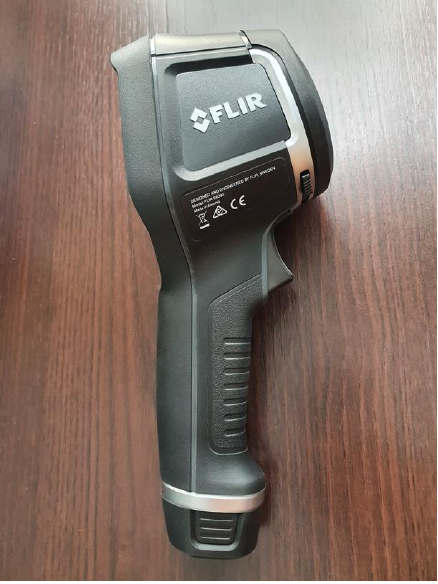
Figure 1. FLIR-E6390 thermal imaging camera used for scientific and research work. Table 1. Technical specifications of the FLIR-E6390 thermal imaging camera.